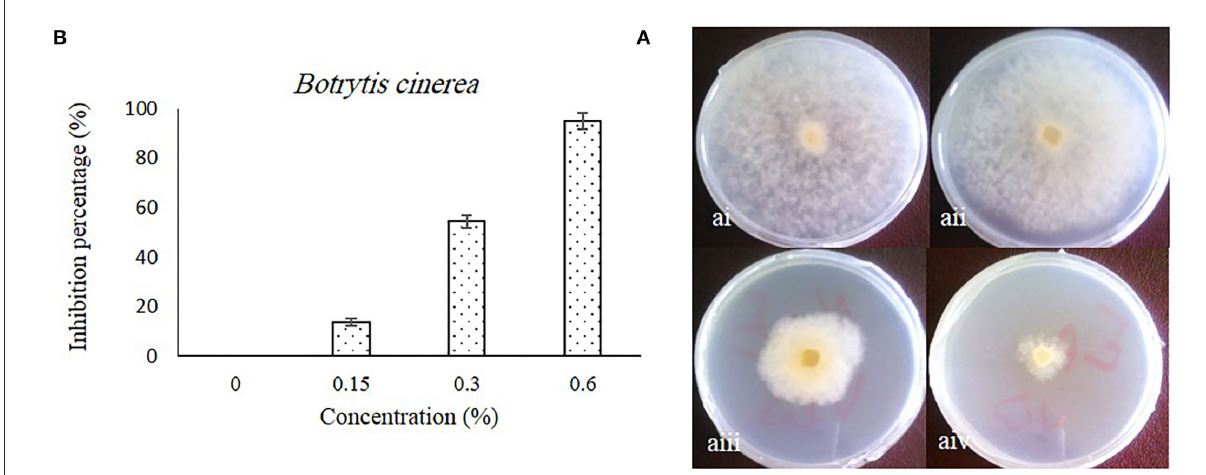
FIGURE1 The effect of different concentrations of caraway oil on B. cinerea in in vitro after 7 d at 27 ◦ C. Colony morphology [ (A) i, ii, iii, and iv]: (A) i, control; (A) ii, 0.15% of caraway oil; (A) iii, 0.3% of caraway oil; and (A) iv, 0.6% of caraway oil. The inhibition percentage of caraway oil on B. cinerea (B) . Values represent mean ± SD of three replications. Different letters indicate significant differences at the 5% level according to the Duncan